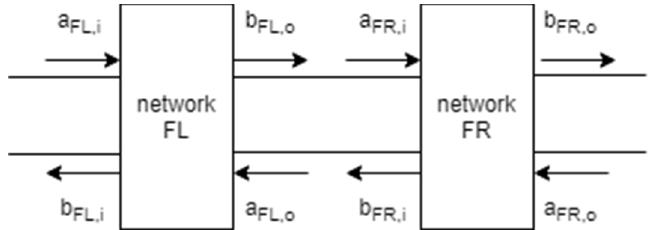
Figure 1. Cascade of two 2-port S-parameter networks: “FL” stands for left feature network and “FR” stands for right feature network.